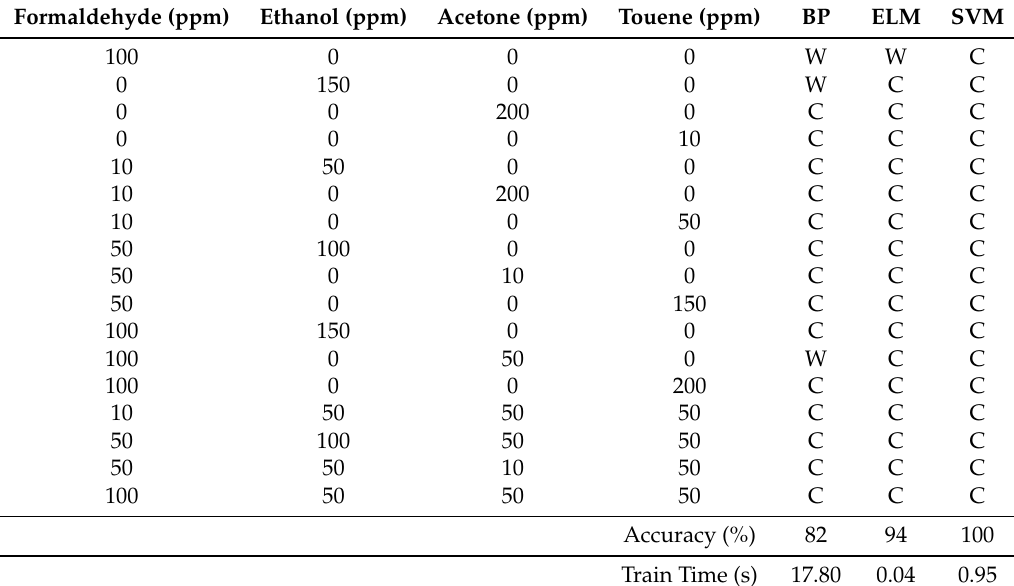
Table 3. Gas sensor arrays reported in Different Literatures